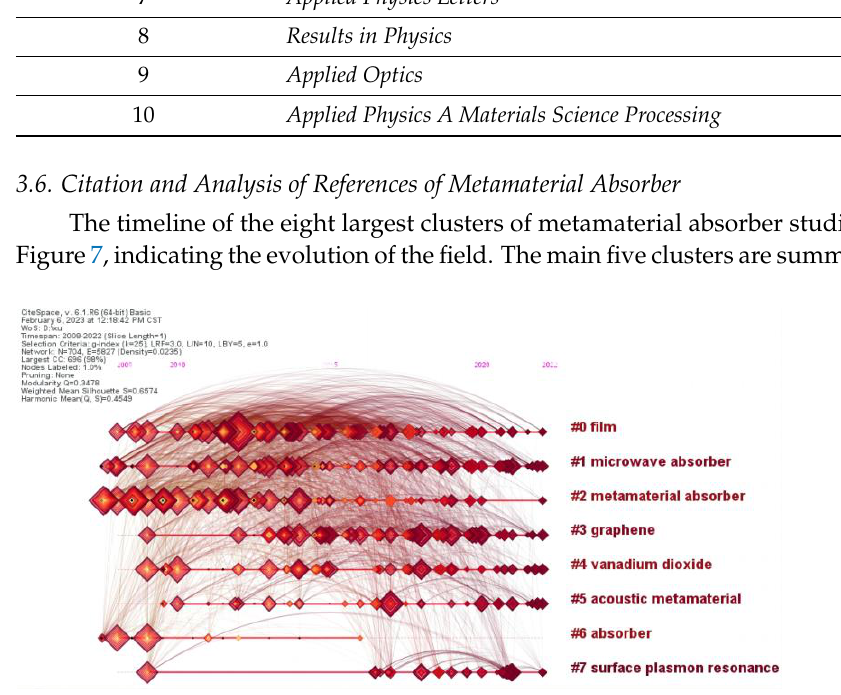
Figure 7. The timeline of the 8 largest clusters of metamaterial absorber.